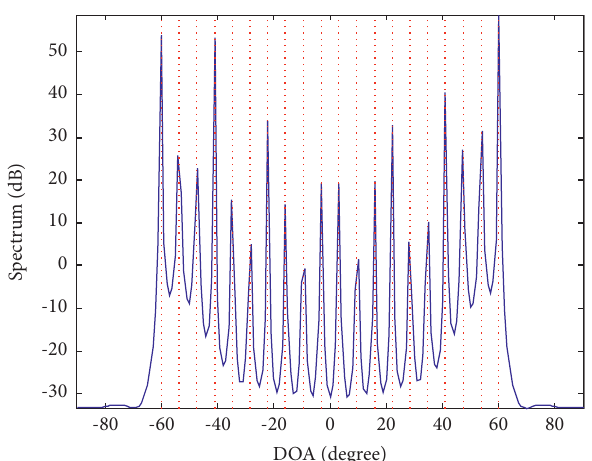
Figure 4: MUSIC spectrum with SNR � 0 dB, T